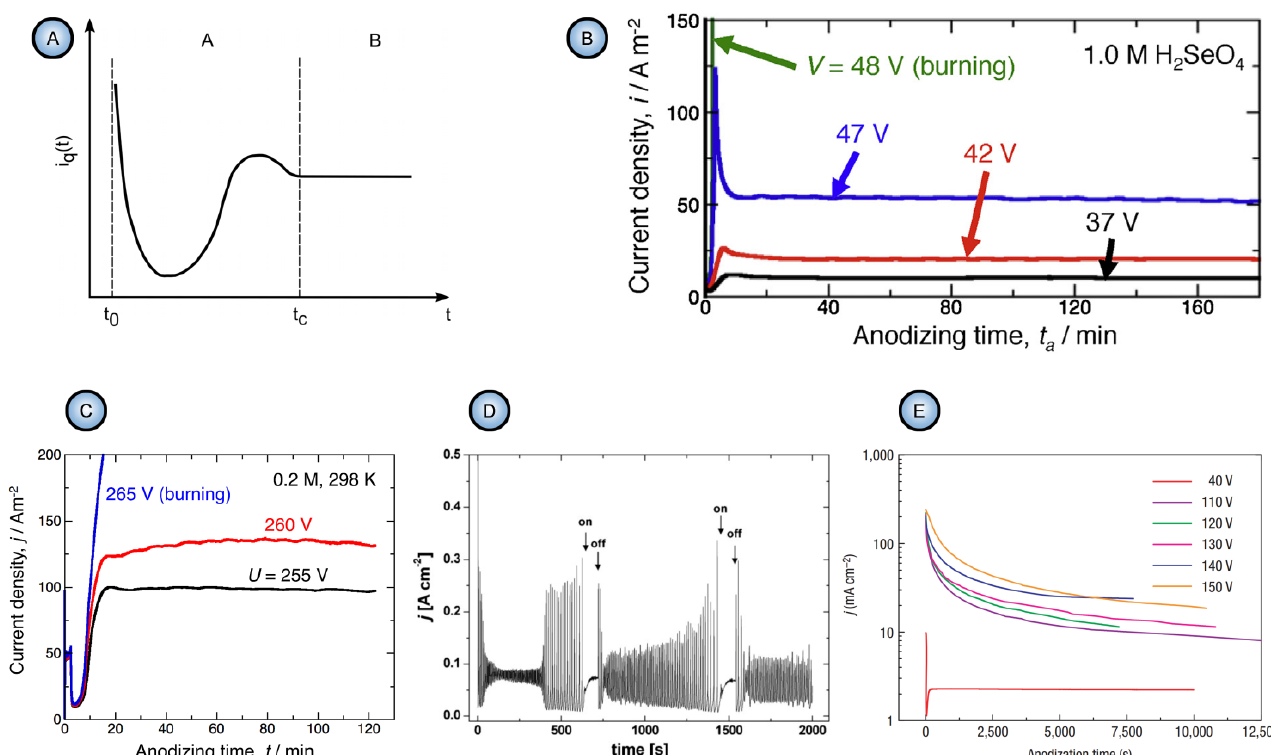
Figure 30. Schematic representation of a j – t curve adopted in the Heinschke–Schneider mathematical model as a basis for describing the general case of PAA formation ( A ), and various shapes of j – t curves which indicate the formation of highly ordered PAA structures in actual experimental situations ( B – E ). Although the curves obtained using a 1.0 M H 2 SeO 4 solution are generally consistent with the model, electric current oscillations are visible at ∆ U = 47 V ( B ). Nonlinear oscillating behavior becomes even more prominent when using 0.2 M etidronic acid electrolyte at ∆ U = 260 V ( C ). The amplitude of oscillations increases during HA in unstirred 0.3 M H 2 C 2 O 4 electrolyte ( D ), making it impossible to define the point t c . If HA is performed in a stirred 0.3 M H 2 C 2 O 4 solution ( E ), the discussed mathematical model is not applicable due to the constant exponential decrease in j with time. Reproduced with permissions from [3,12,66,72,150]. Copyright 2020 American Chemical Society, 2014 and 2016 Elsevier, 2010 Wiley, and 2006 Nature.